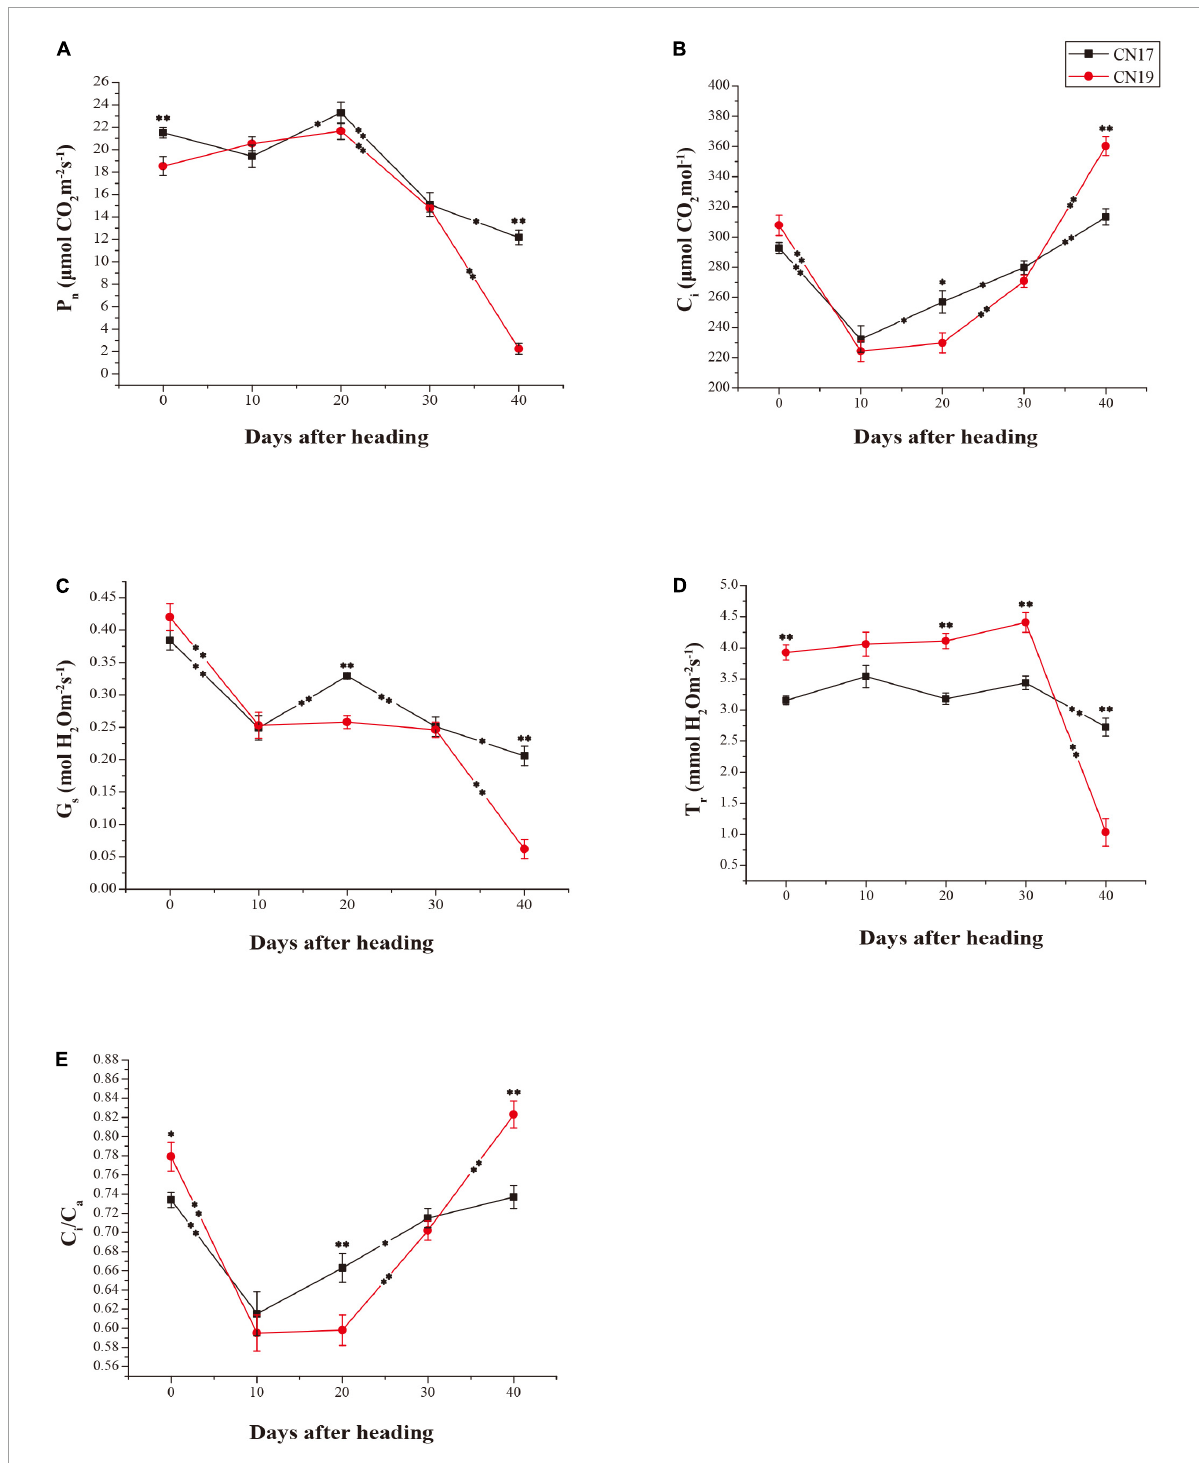
FIGURE1 Differences in photosynthetic parameters between stay-green cultivar CN17 and non-stay-green cultivar CN19 after heading. (A) Net photosynthetic rate ( P n ); (B) Intercellular carbon dioxide concentration ( C i ); (C) Stomatal conductance ( G s ); (D) Transpiration rate ( T r ); (E) Ratio of internal to atmospheric CO 2 concentration ( C i / C a ). The bars indicate the mean ± standard error ( n = 10). ∗ and ∗∗ for significant differences at P ≤ 0.05 and P ≤ 0.01, respectively; the asterisks within the lines for significant differences between adjacent time points for the same wheat cultivar; the raised asterisks for significant differences between genotypes at each time